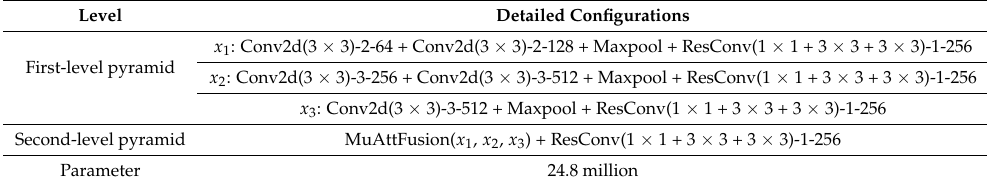
Table 2. Two-level light-weight spatial feature fusion pyramid configurations. The module parameters are denoted as “module name(receptive fields)-number of modules-number of module output channels”.